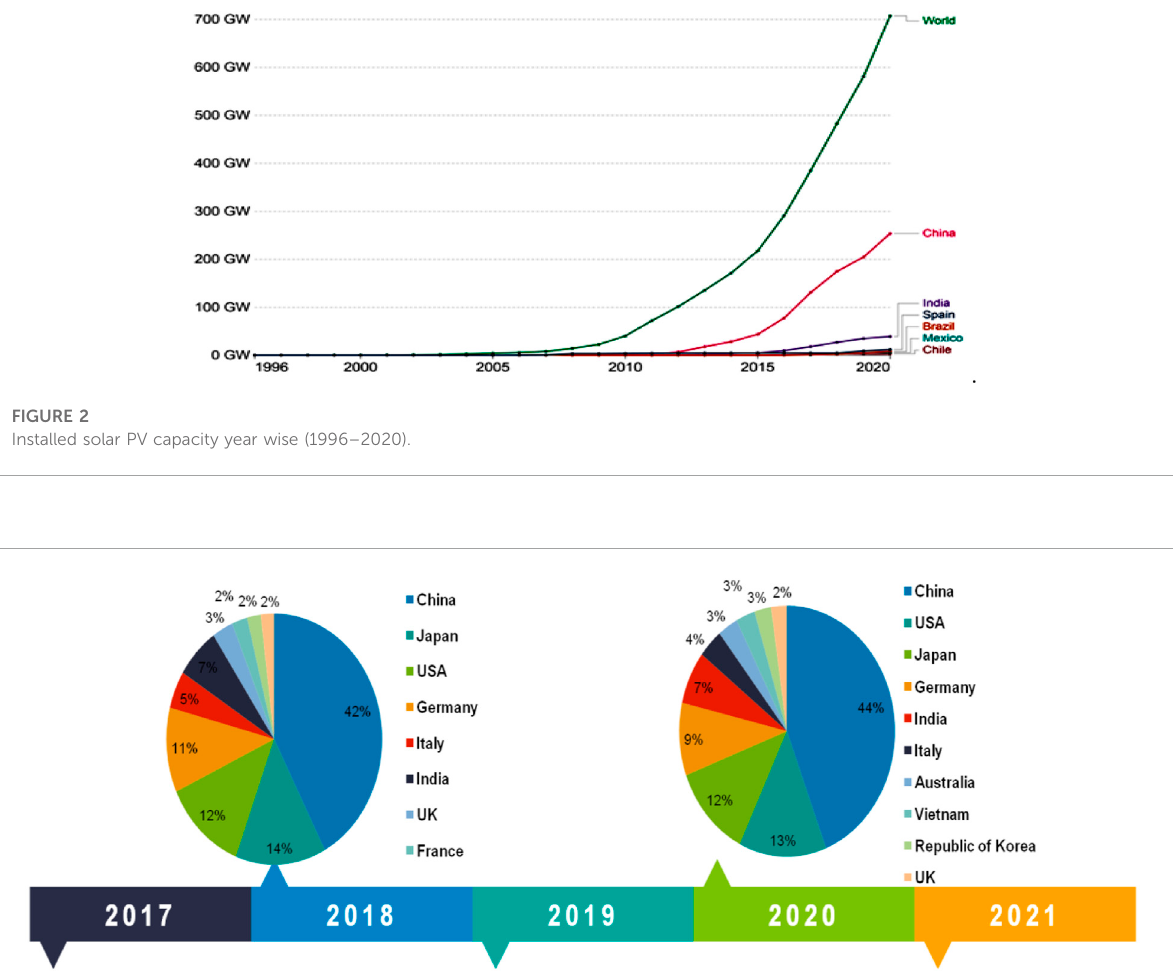
and Pindoriya (2019). A wavelet transformation is introduced to extract frequencies of input data results to achieve diversity and accuracy in PV power forecasted results; a neural network ensemble scheme is proposed by Raza et al. (2019). In this scheme, fi ve different feed-forward neural networks (FNNs) are trained using the particle swarm optimization (PSO)